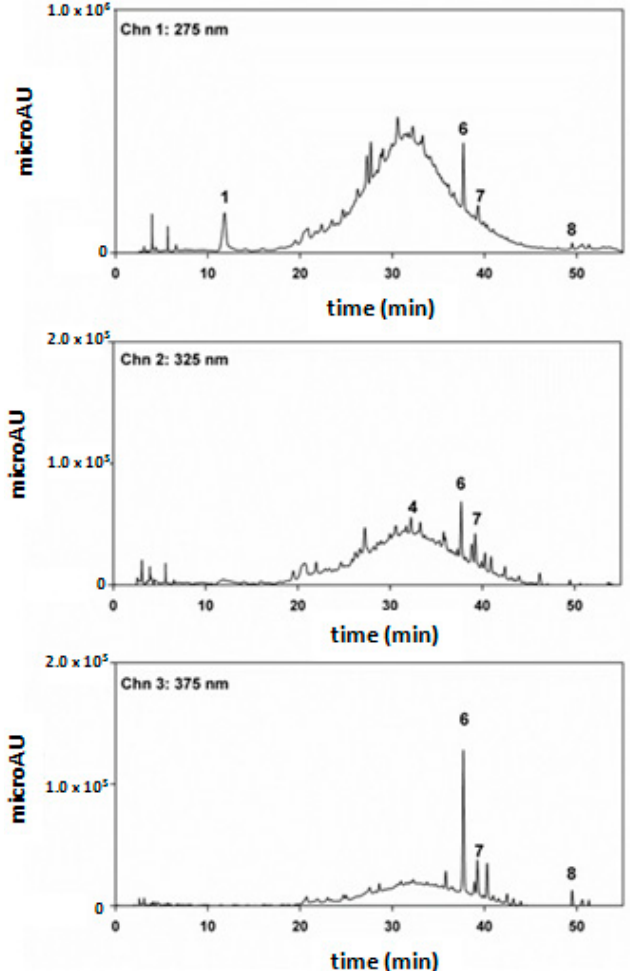
Figure 1. Chromatographic separation (HPLC/DAD) of chestnut shell extract monitoring atthe wavelengths of 275, 325, and 375 nm. The numbers indicate the following molecules: gallic acid (1), syringic acid (4), ellagic acid (6), rutin (7), and quercetin (8).